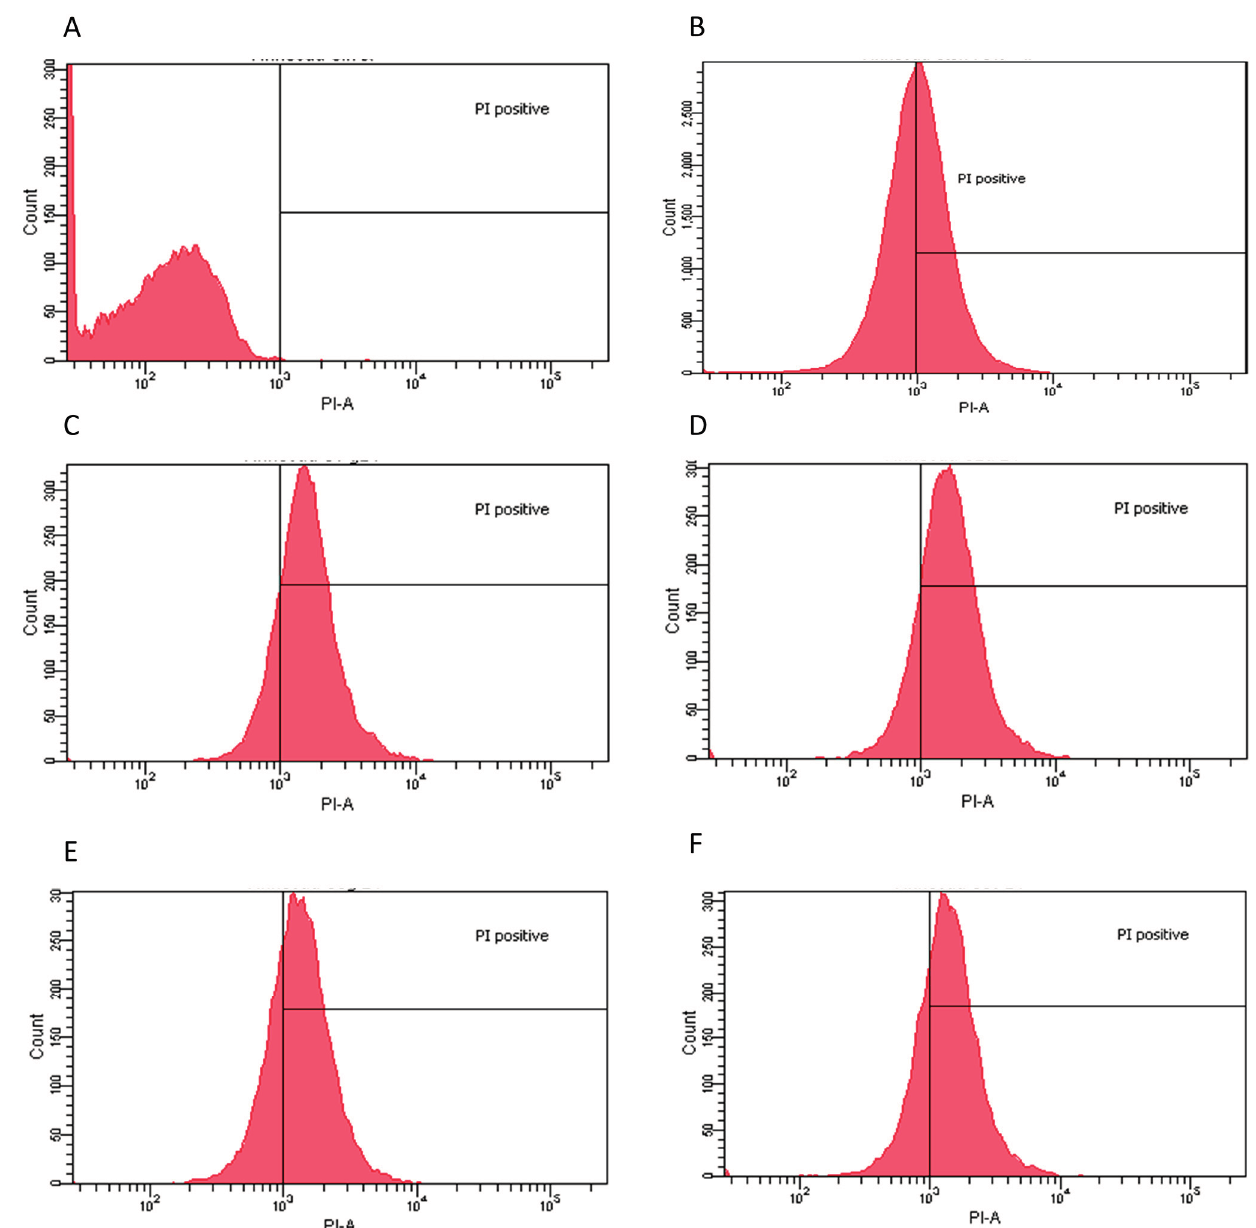
Figure 3. Flow cytometry histograms derived from scatter plots showing fluorescence of live (<103) or dead (>103) of L. innocua stained with PI post 24 h incubation with controls or extracts. X-axis corresponds to the PI positive marked microorganisms and Y-axis to the total cell count. ( A ) L. innocua sample PI negative control, 99.9% viability; ( B ) L. innocua incubated for 30 min with ethanol 70% PI positive control 46.4% viability; ( C ) water dry leaf non-boiled extract 4 μ g/mL, 17.5% viability; ( D ) water non-dried leaves non-boiled 2.5 μ g/mL, 16.7% viability; ( E ) ethanol 4 μ g/mL, 28.5% viability; and ( F ) water dry leaf boiled 2 μ g/mL, 25.6%